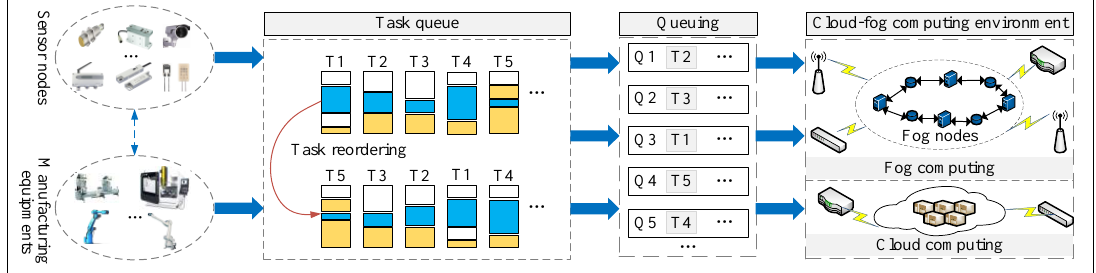
Figure 3. Task processing flow in the cloud-fog computing environment.